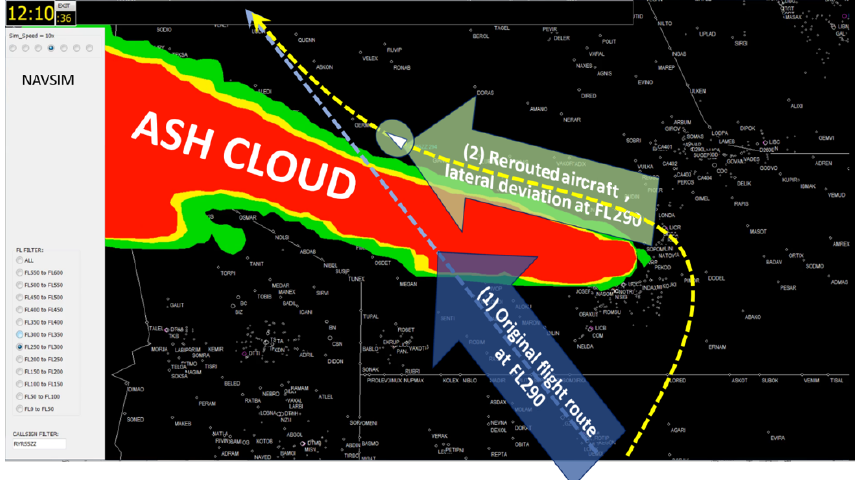
Figure 14. Volcanic ash (red ≥ 4mgm − 3 , yellow 2–4mgm − 3 , green 0.2–2mgm − 3 ) reroute calculated by FLIGHTKEYS and simulated with NAVSIM/USBGSim (University of Salzburg), laterally and vertically avoiding ash concentration.